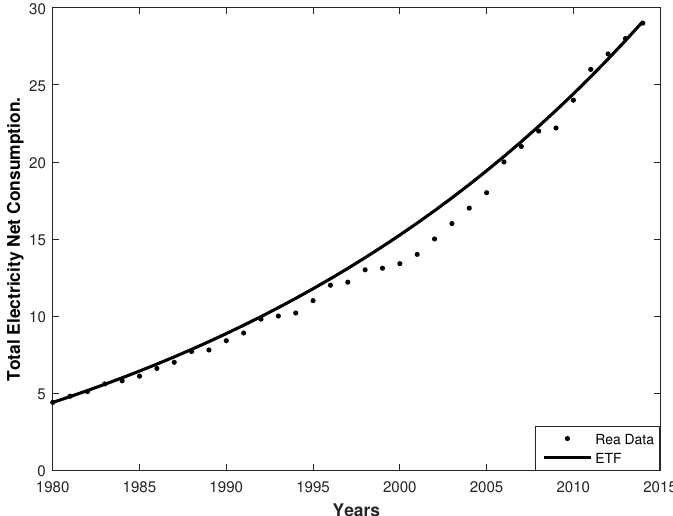
Figure 3. The data observed versus those fitted by the stochastic Brennan–Schwartz Diffusion Process